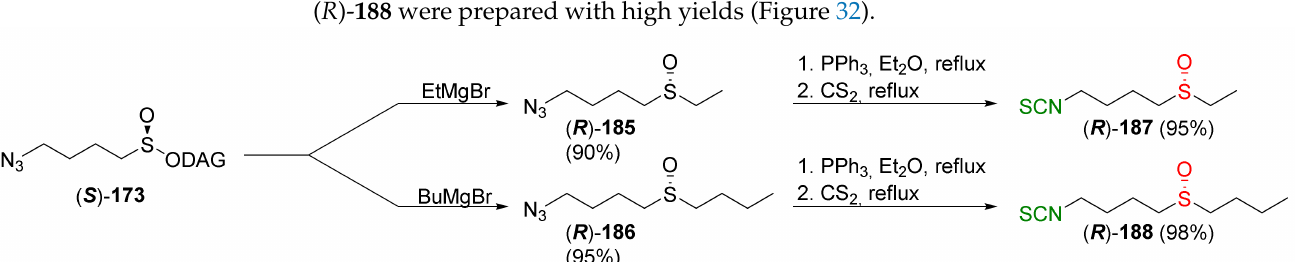
Figure 32. Synthesis of enantiopure analogues of ( R )-SFN-( R )- 187 and ( R )- 188 .